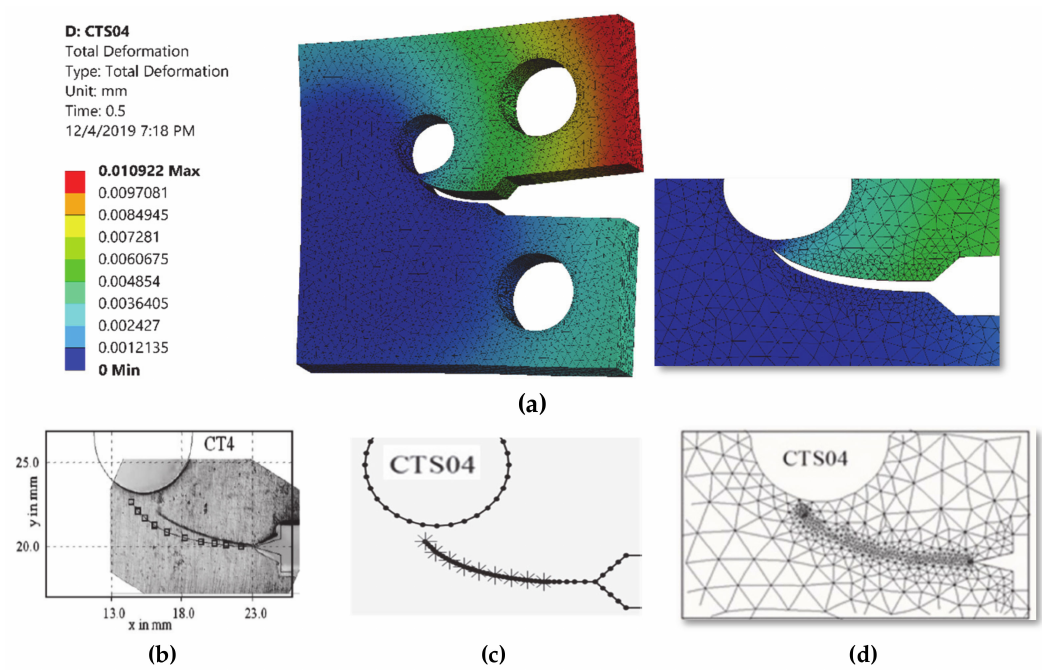
Figure 7. Predicted crack growth direction of CTS04: ( a ) current study result, ( b ) experimental and numerical results of [28], ( c ) BemCracker2D [16] and ( d ) Quebra2D [16].